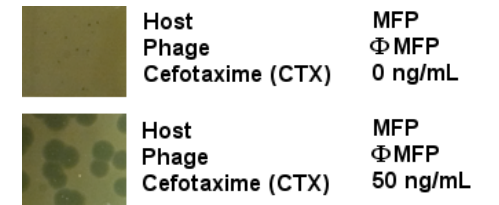
Figure 2. Plaque sizes of phage w MFP on E. coli MFP with and without 50 ng/mL of cefotaxime (CTX) in Luria agar